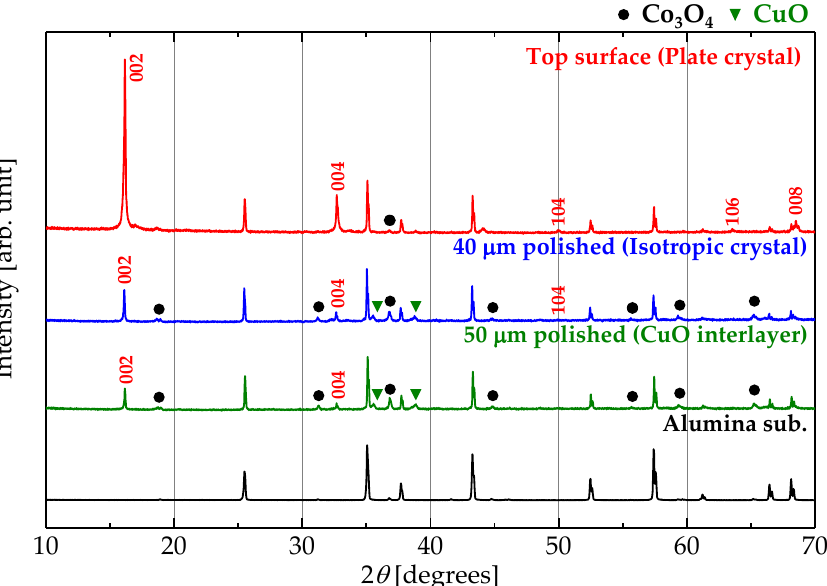
Figure 6. XRD (CuK α ) patterns of the plate-crystal layer, the isotropic crystal layer, the CuO interlayer, and the alumina substrate in the Na 0.5 Co 0.9 Cu 0.1 O 2 thick film. Each layer was exposed by polishing from the surface of the film.